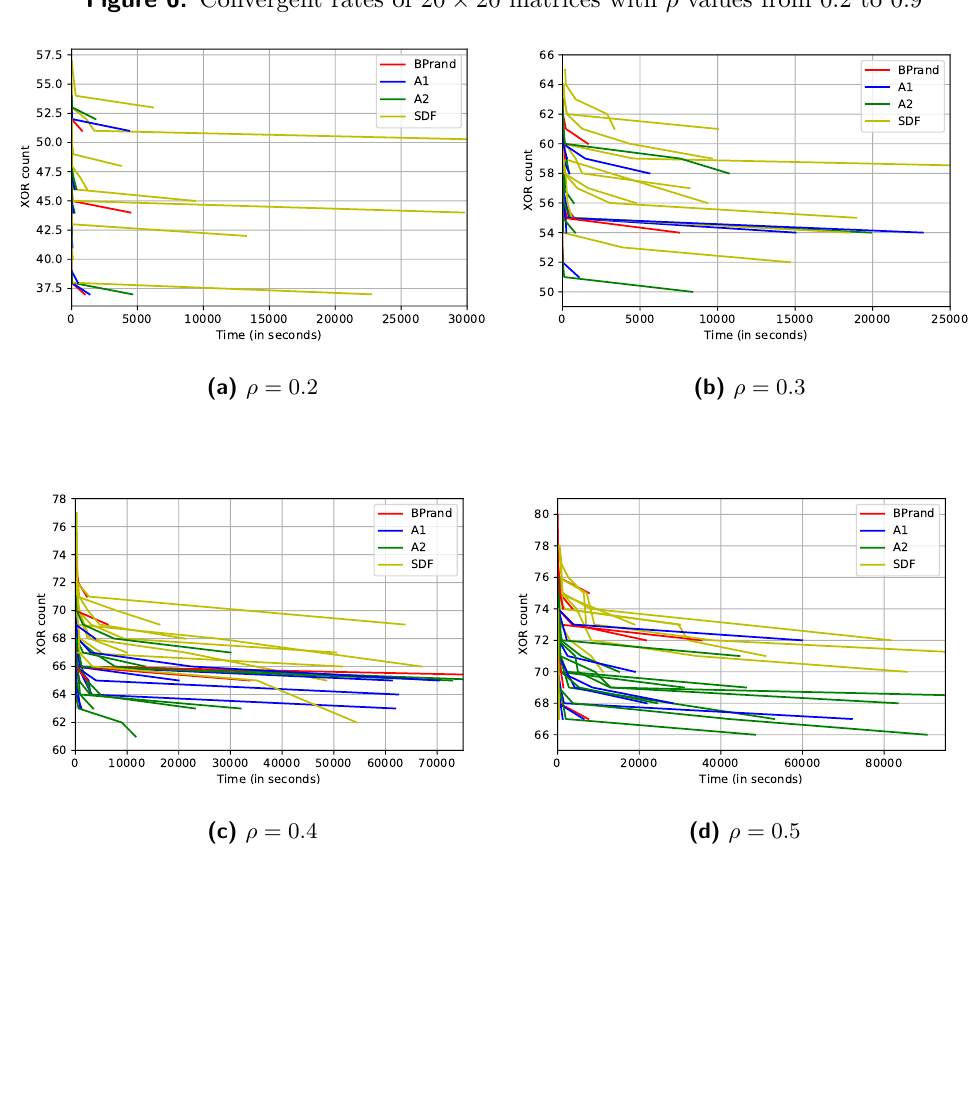
Figure 6: Convergent rates of 20 × 20 matrices with ρ values from 0.2 to